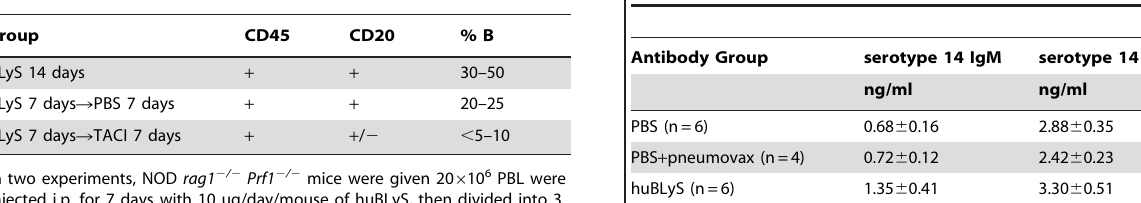
Table 4. Induction of a thymus-independent immune response in human PBL engrafted NOD rag1 2 / 2 Prf1 2 / 2